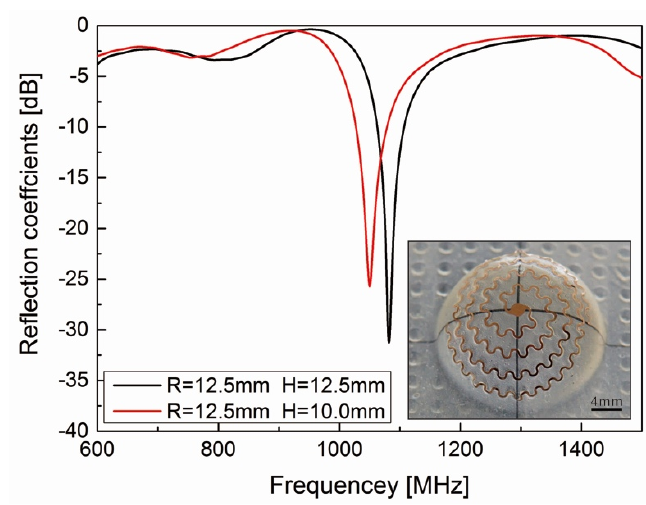
Figure 5. Electrical performance of antennas. The photos of antennas were also demonstrated.